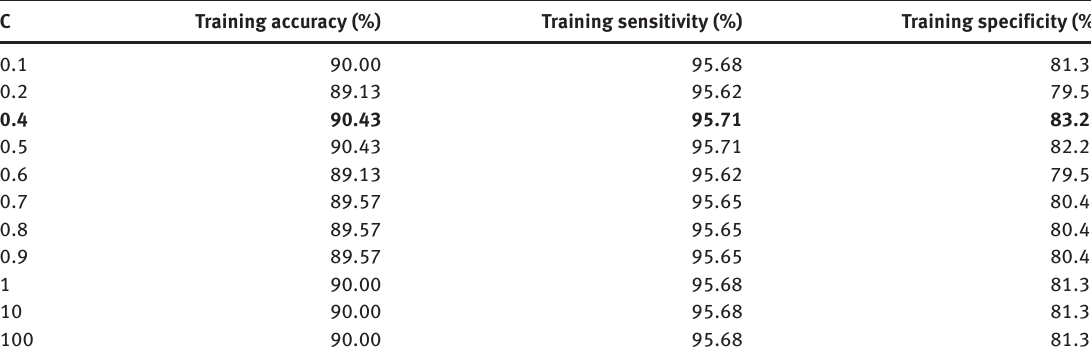
Figure 4: Performance plot. Table 3: Simulation results on the PID training dataset for various C